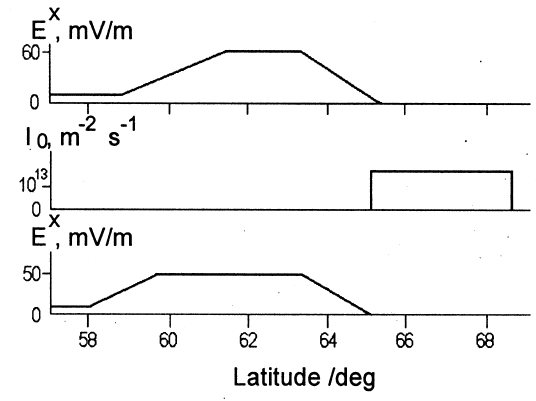
Fig. 2. Latitudinal dependence of the model input parameters at the upper boundary of the region of model simulation. The meridional component of the electric field E x used to simulate the electron density in Fig. 1c, the flux of soft electrons I 0 , and the meridional component of the electric field E x used to simulate the electron den- sity in Fig. 1d are illustrated in the top, middle, and bottom panels,